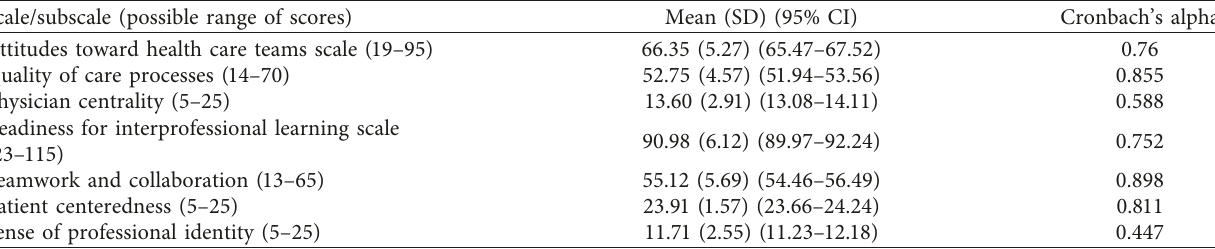
Table 1: Mean scores and reliability of scales and